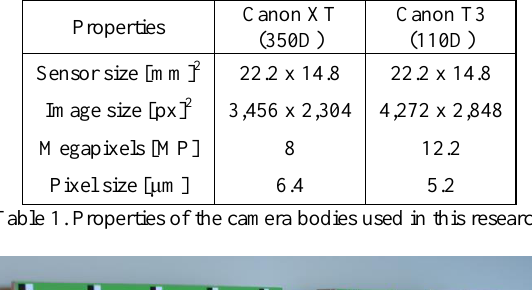
Figure 3. Residual quiver plot for the Canon XT (350D) with